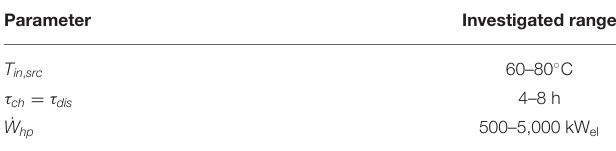
TABLE 6 | Investigated configurations. Parameter Investigated